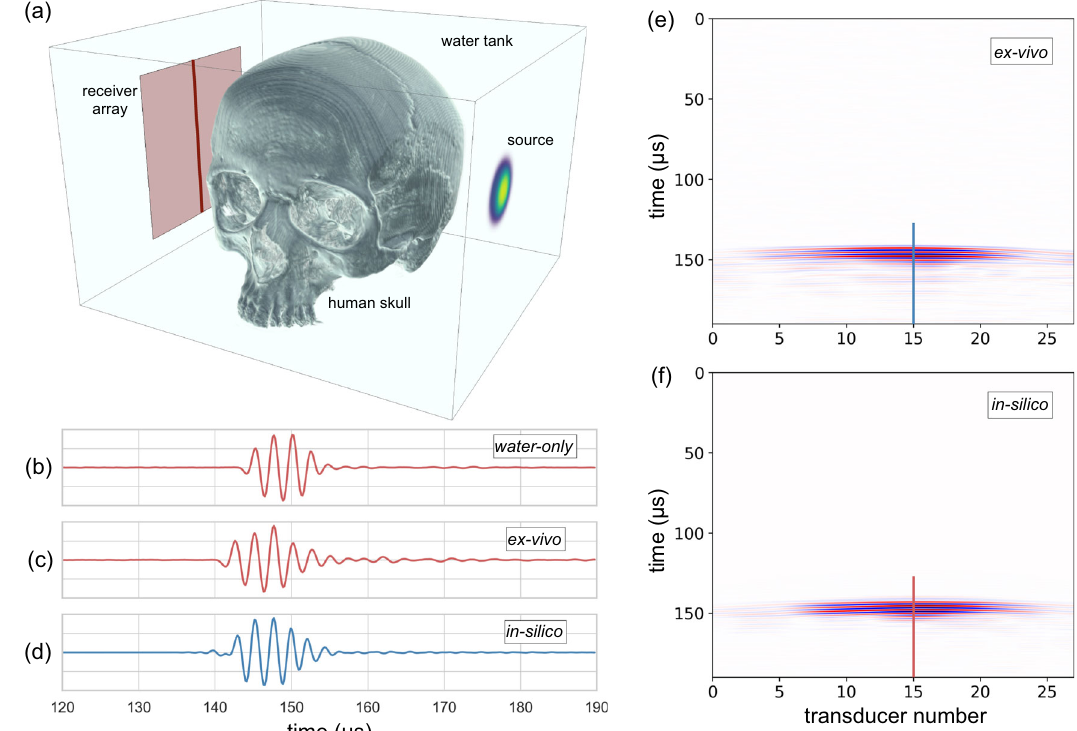
Fig. 7 Ex vivo and in silico data after transmission across the head. a The geometry of the ex vivo laboratory experiment. b Data recorded in the laboratory by the central transducer without the skull present. c The equivalent ex vivo data recorded with the skull. d The equivalent in silico data with the skull. e Laboratory ex vivo data recorded on a fi nely sampled linear array with the skull. f The equivalent numerical data simulated in 3D. The physical skull and the numerical model are nominally the same, but differ in detail, and the numerical model does not include the effects of scattering by the physical transducers and their supporting hardware. Figures b – d are normalised to their largest amplitude; the un-normalised amplitudes in b are about fi ve times larger than those in c